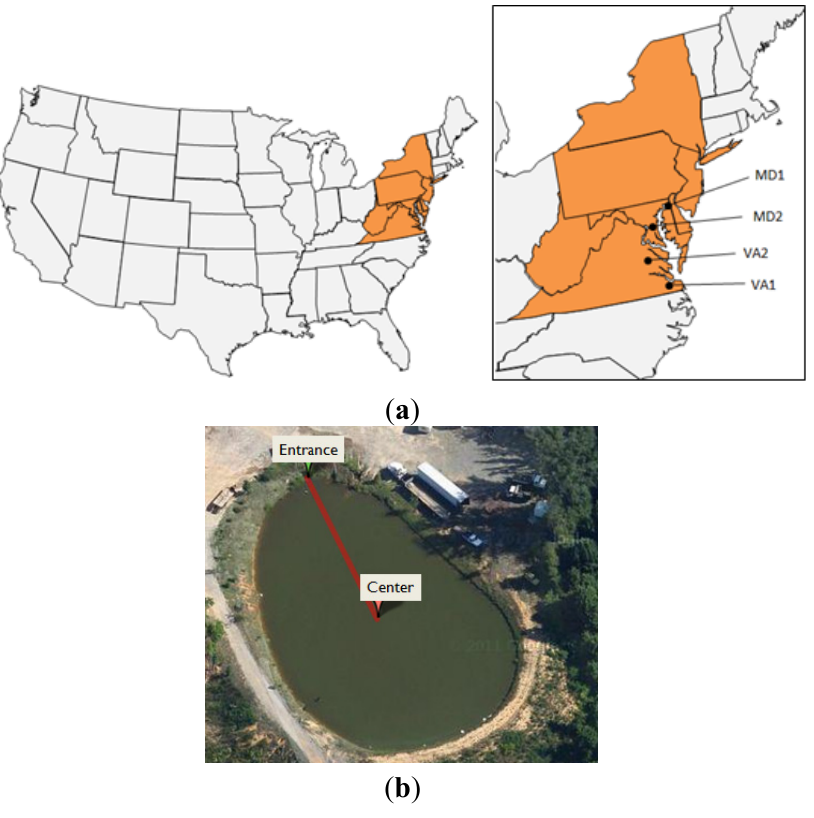
Figure 1. ( a ) Location of all four nurseries studied in Mid-Atlantic region in USA and ( b ) layout of reservoir VA21 at Nursery